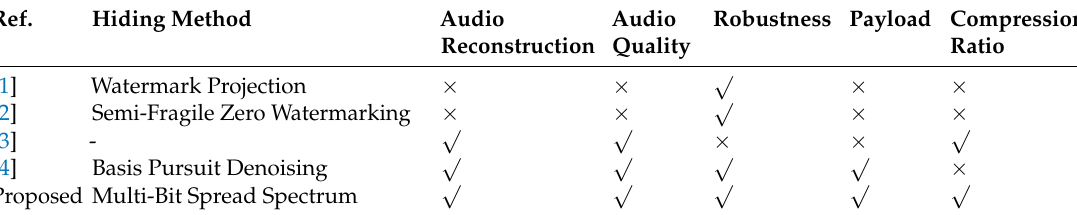
Table 8. Comprehensiveness comparison.